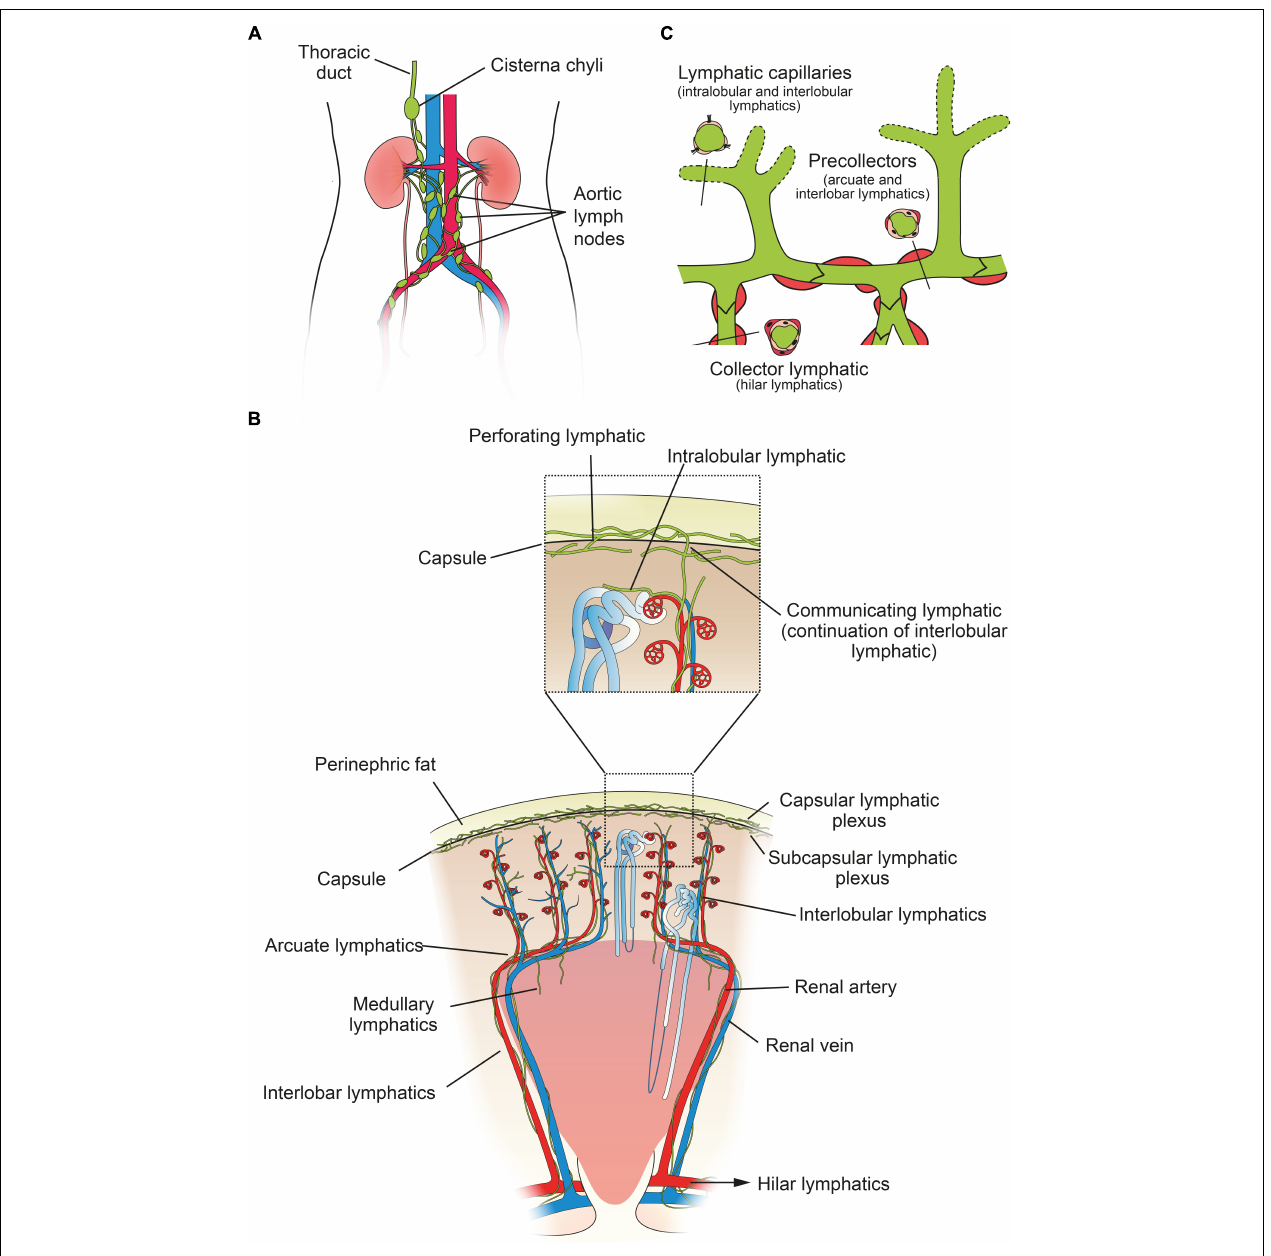
FIGURE 1 | Structure of the human renal lymphatic system. (A) Lymph passes from 4–5 renal hilar lymphatics on each kidney to various groups of aortic lymph nodes. Most lymph draining from the kidney collects in the cisterna chyli and is drained via the thoracic duct into the central venous circulation in the neck. (B) Schematic diagram of a human renal lobe. Blind-ended lymphatic capillaries begin in the substance of a renal lobule as intralobular lymphatics, which in turn become interlobular lymphatics. From here, lymph can flow either toward the capsule or toward the hilum. Valves are present at the level of the capsule and arcuate vessels to prevent backflow. Intra-renal arteries in red and intra-renal veins in blue. Insert shows detail of communicating and perforating lymphatics that pierce the renal capsule. (C) Schematic showing morphology of renal lymph vessels. Lymphatic vessels vary morphologically between initial capillaries (no basement membrane or smooth muscle), pre-collectors (some smooth muscle and occasional valves) and collectors (continuous basement membrane and smooth muscle layer, valves present). Figure based on information from O’Morchoe and O’Morchoe (1988) and Seeger et al.